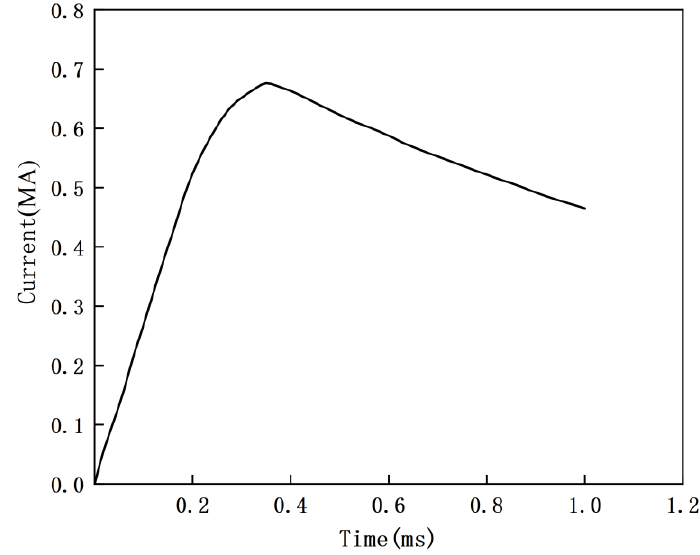
Figure 10. Waveform diagram of excitation current in case